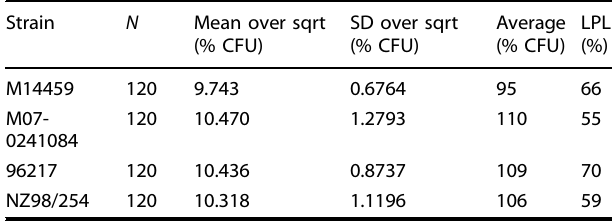
Table 3. Lower one-sided 99% prediction limits of survival rates for each indicator